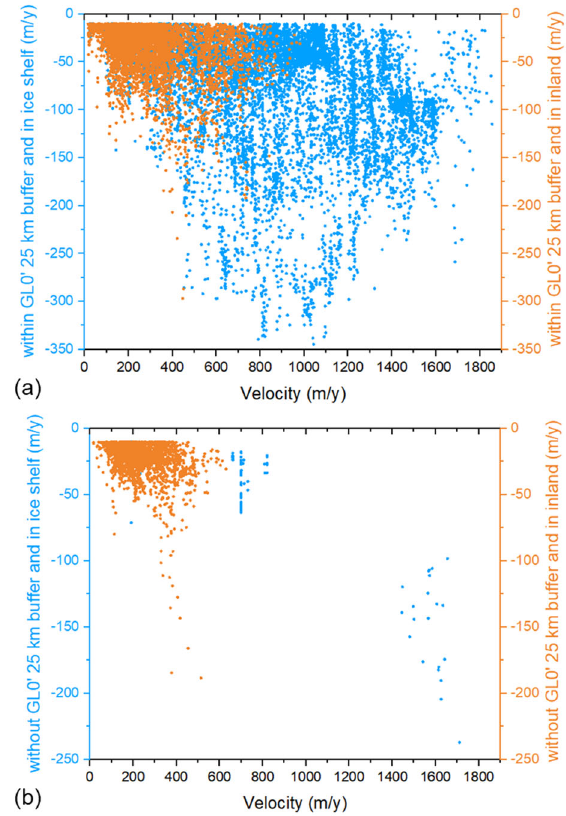
Figure 3 . The distribution of the corrected values (a) within GL0’25 km buffer and (b) without GL0’25 km buffer, the blue dots represent the corrected values in ice shelf and the orange dots represent the corrected values in